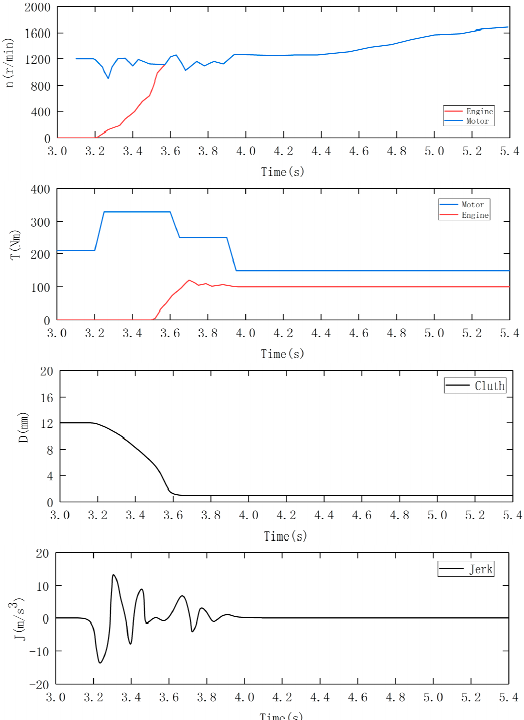
Figure 8. Simulation results of TTC.